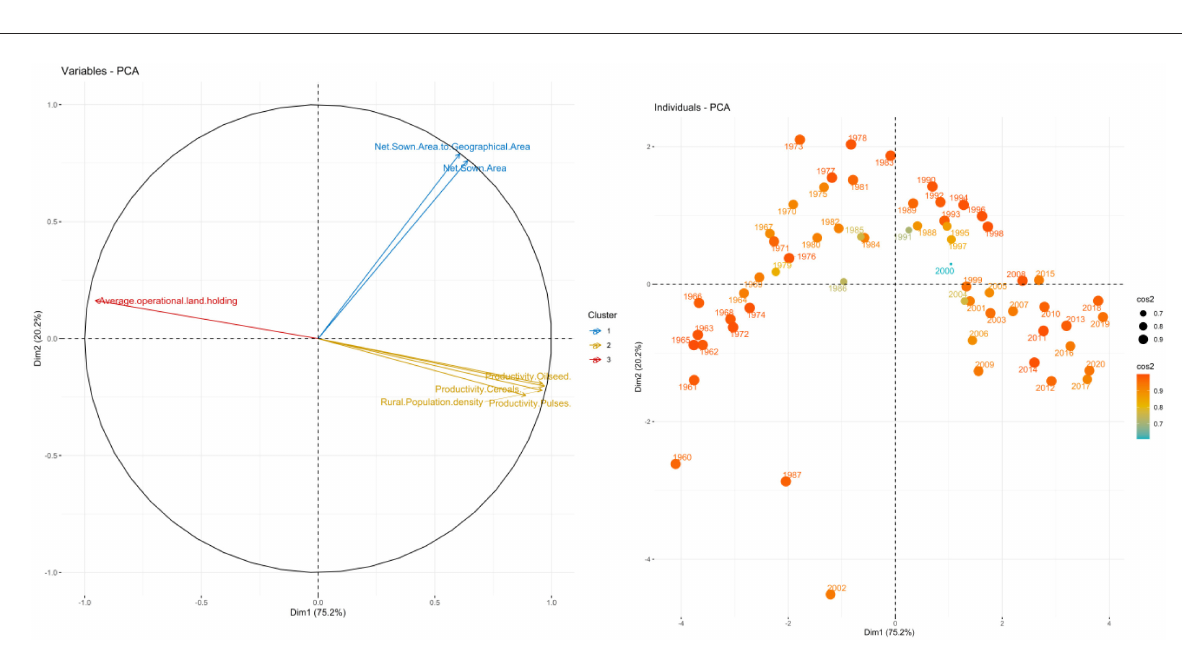
On the sensitivity indicator, its six factors were aggregated to one principal component because it explained more than 75 percent variation having eigenvalue 5.26 ( > 1), and the PC1 non-rotated loading values showed that average operational land holding size and the productivity of cereals